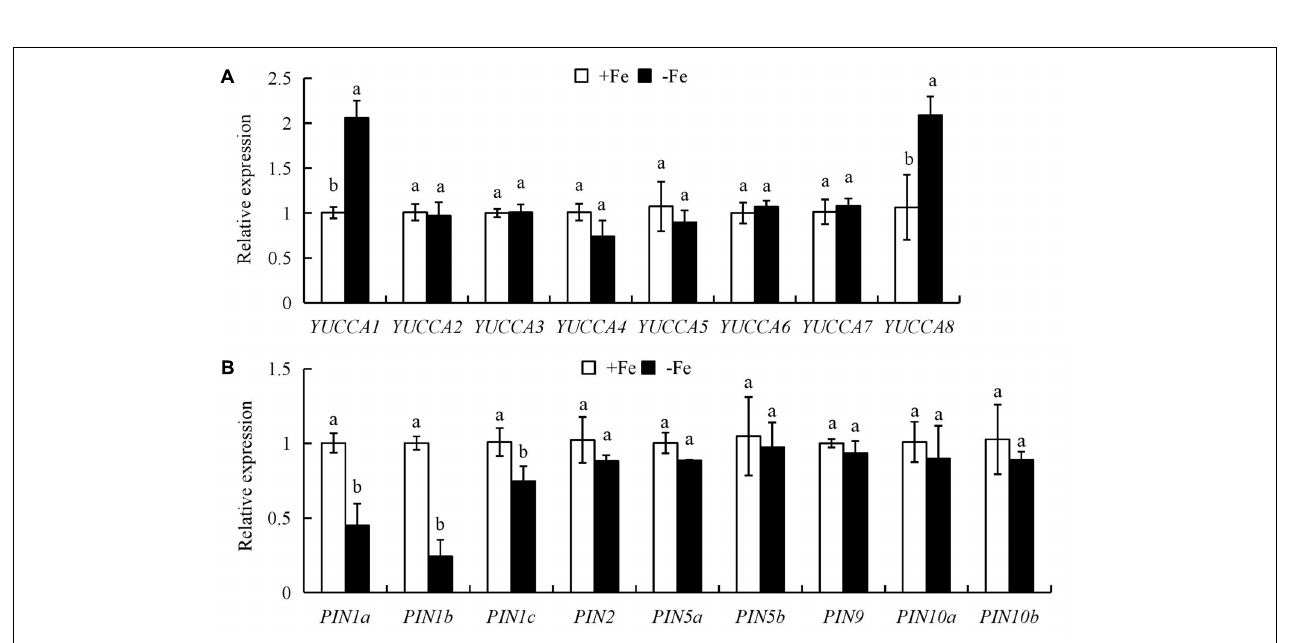
FIGURE 4 | Quantitative reverse transcription (qrt)-PCR analysis of YUCCA and PIN family genes in rice seedlings. Rice seedlings were grown in hydroponic media containing − Fe (0 µ M) and +Fe (20 µ M) for 14 days. (A) The expression of OsYUCCA genes in the first leaf. (B) The expression of OsPIN genes in roots. Relative mRNA levels were normalized for individual gene relative to Os ACT . Data are means ± SE and bars with different letters in the same gene indicate significant difference at P < 0.05 tested with ANOVA.